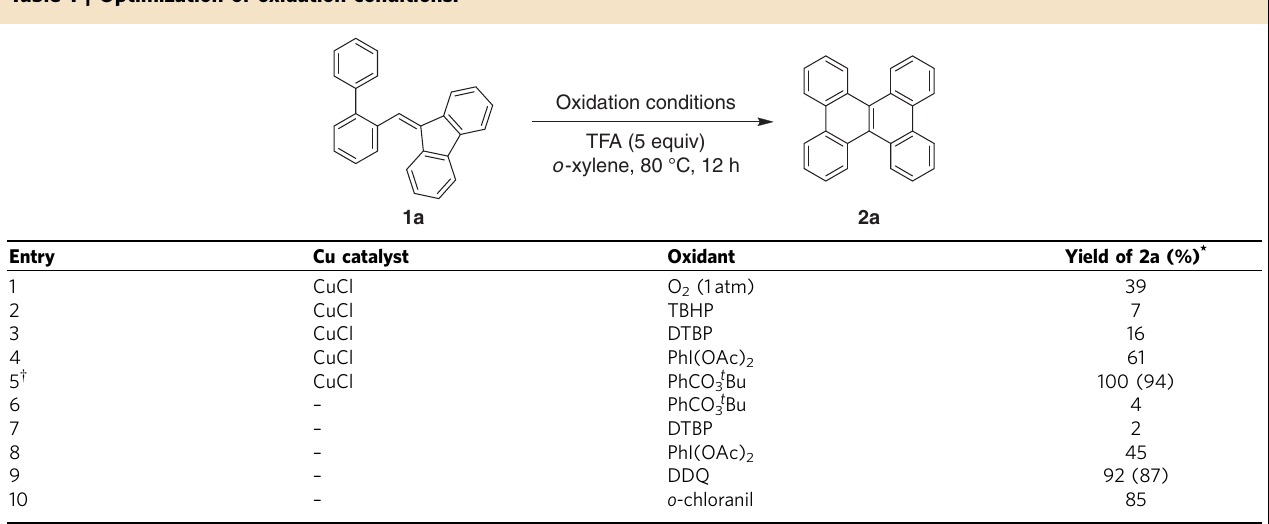
Table 1 | Optimization of oxidation